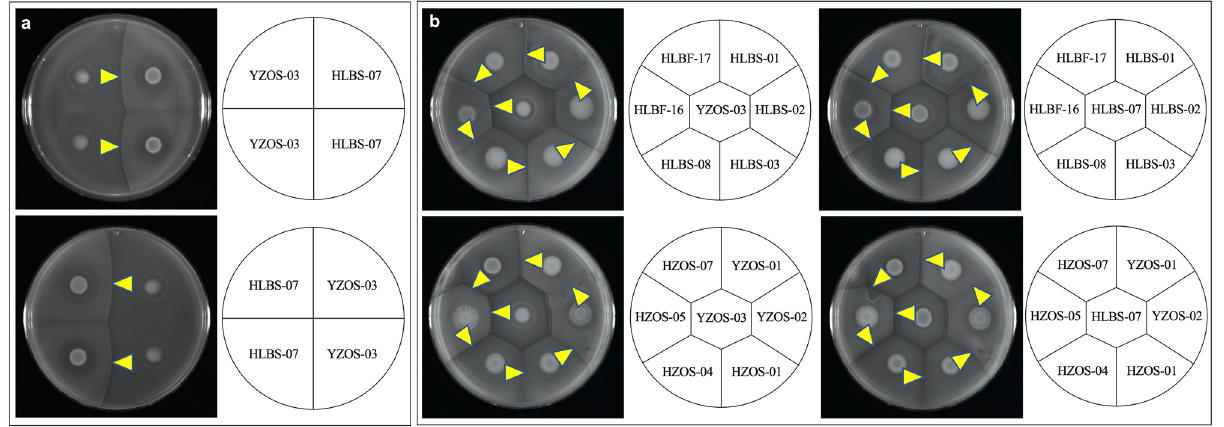
Figure 5. The formation of territory among the bacteria isolated from Andamia tetradactylus and Entomacrodus stellifer . ( a ) Two individual colonies of HLBS-07 and YZOS-03 strains belonging to V. alginolyticus were grown on Zobell medium at 30 °C for 2 days. ( b ) The indicated strains belonging to V. alginolyticus were grown on Zobell medium at 30 °C for 2 days. Arrowheads point to the boundary between strains.